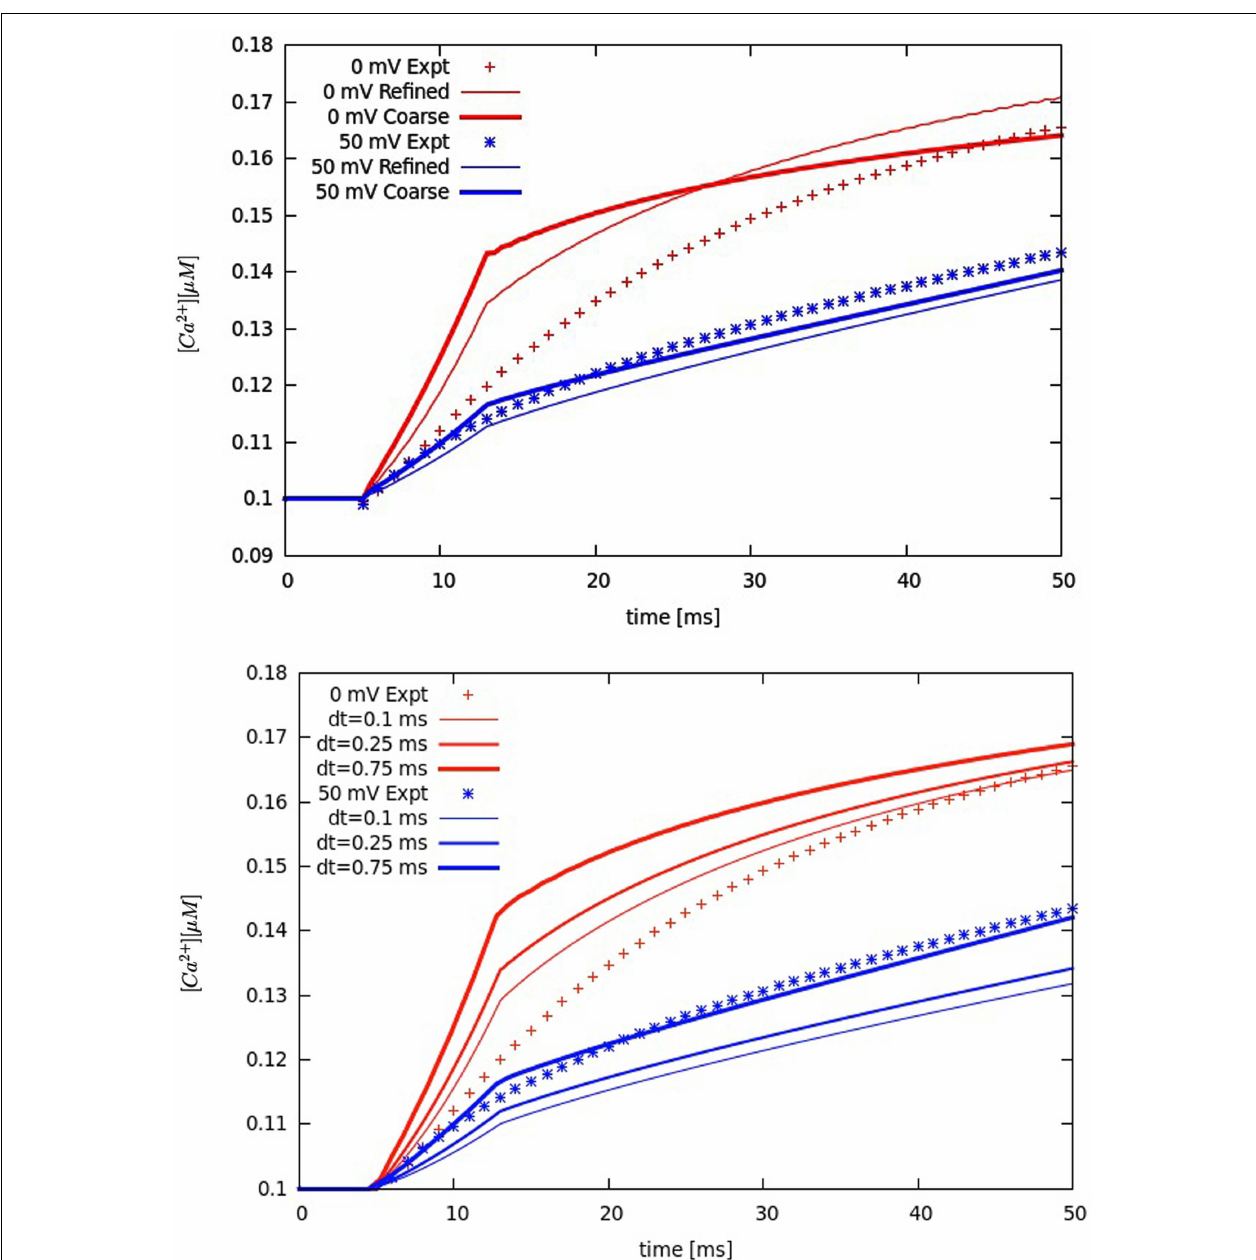
FIGUREA1 | Solution convergence analysis. Upper panel: refining the original mesh. Lower panel: changing the original time step of 0.5ms. Global Ca 2 + transients experimentally measured ( symbols ). Membrane voltage at 0mV ( red lines and symbols ) and at + 50mV ( blue lines and symbols ). [Na + ] i